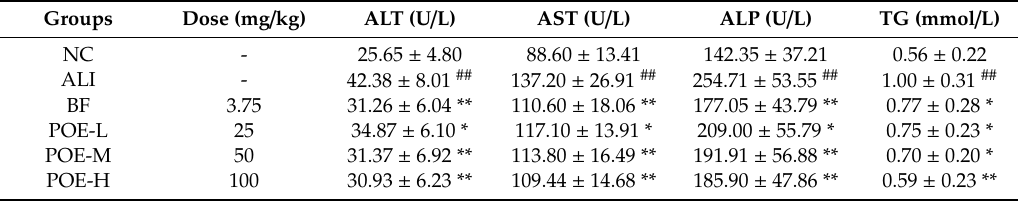
Table 1. E ff ects of POE on serum biochemical indicator in alcoholic liver injury rats.